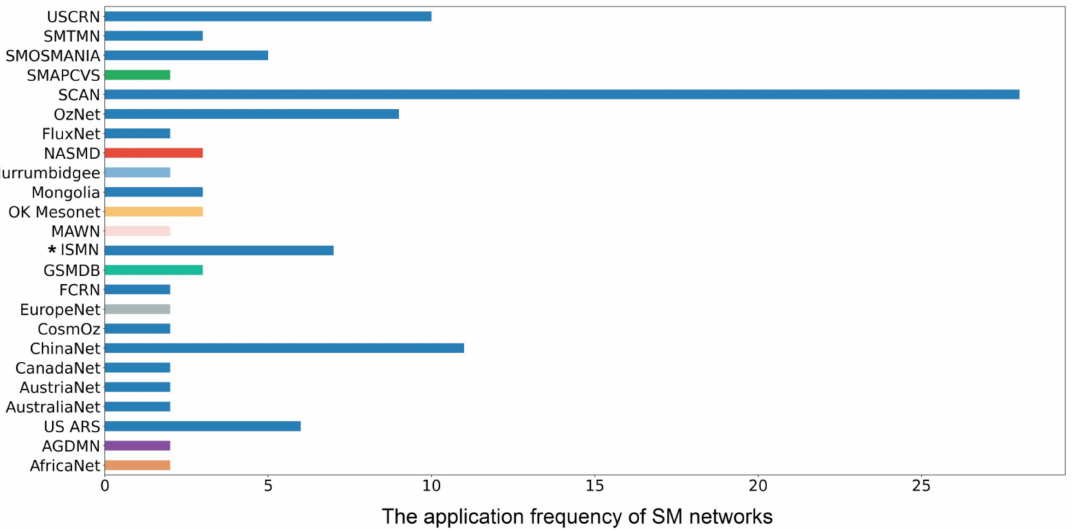
Figure 1. The application frequency of SM networks used in assimilation studies from the selected papers in the time interval 2005–2019. The acronyms are explained in the Abbreviations. ISMN sub-networks are shown in blue and other networks have different colors; * ISMN in the vertical axis includes papers that used the ISMN network but did not specify the subcategories of